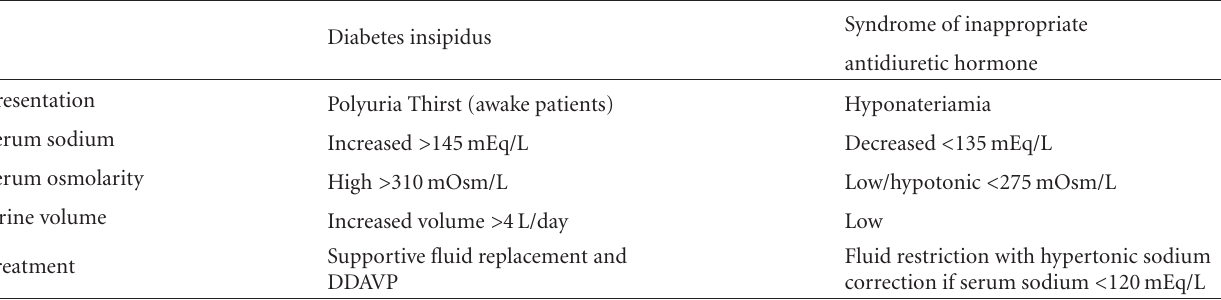
Table 3: Di ff erences between diabetes insipidus and syndrome of inappropriate antidiuretic